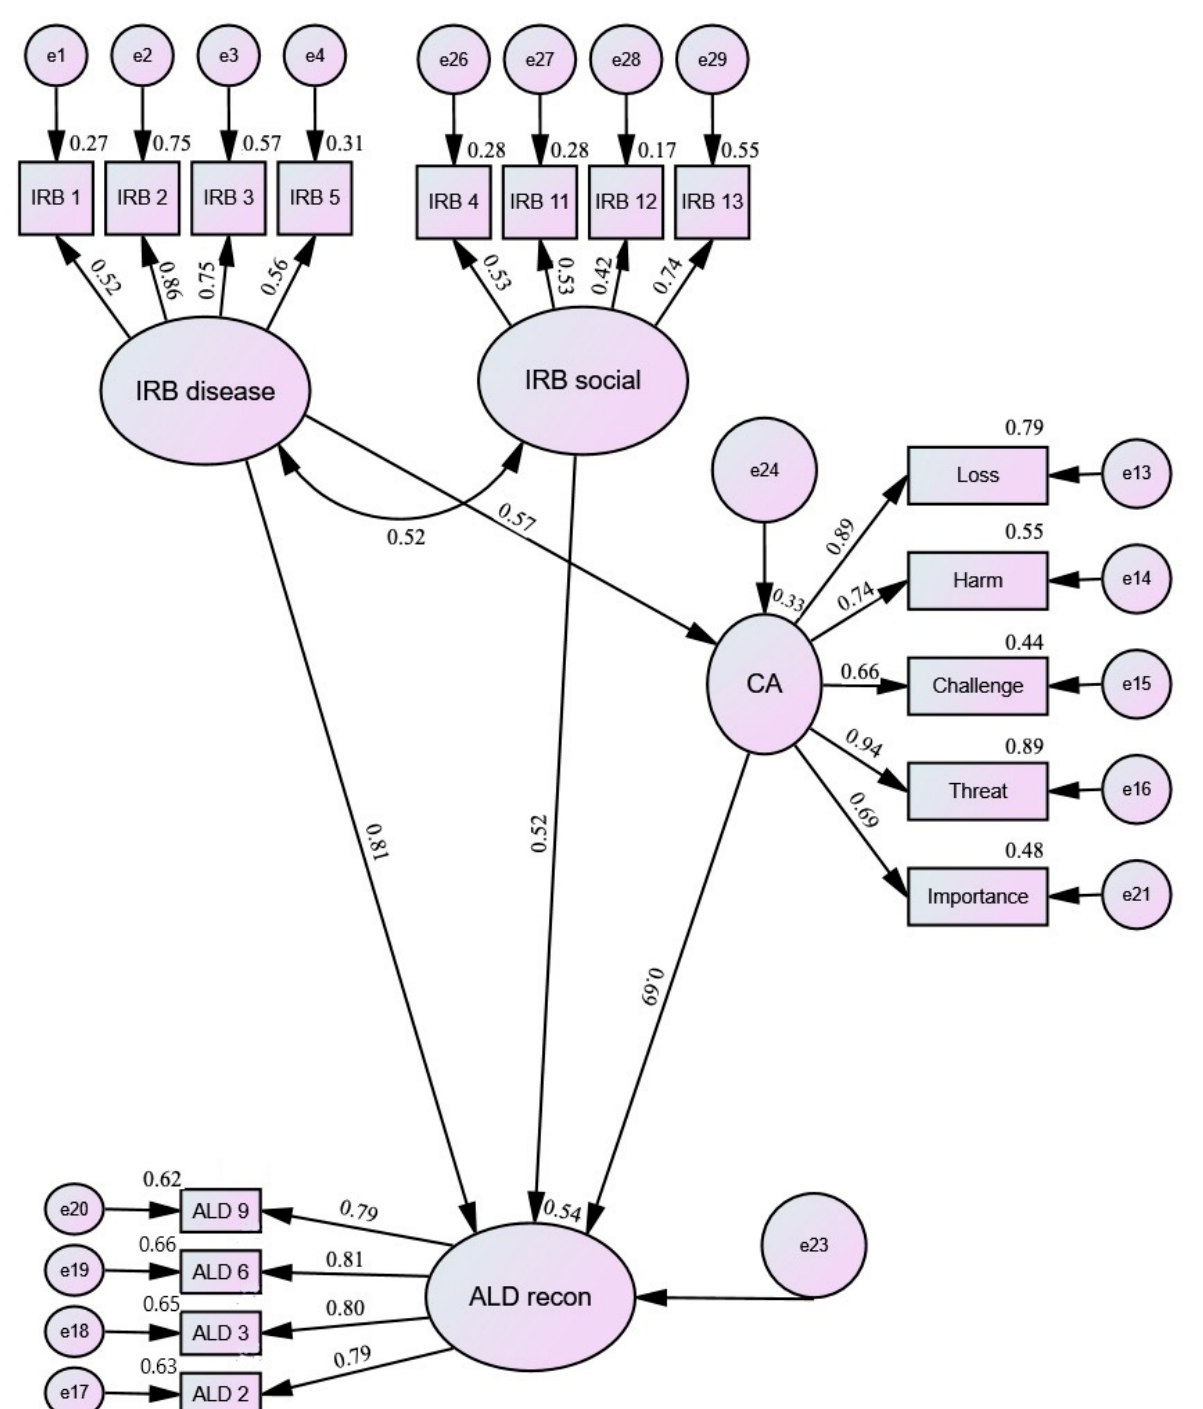
Figure 3. Cognitive factors and ALD Reconcilement: Path diagram. IRB—Illness-related Beliefs; CA—Cognitive Appraisal; ALD recon—Acceptance of Living with the Disease: Reconcilement.